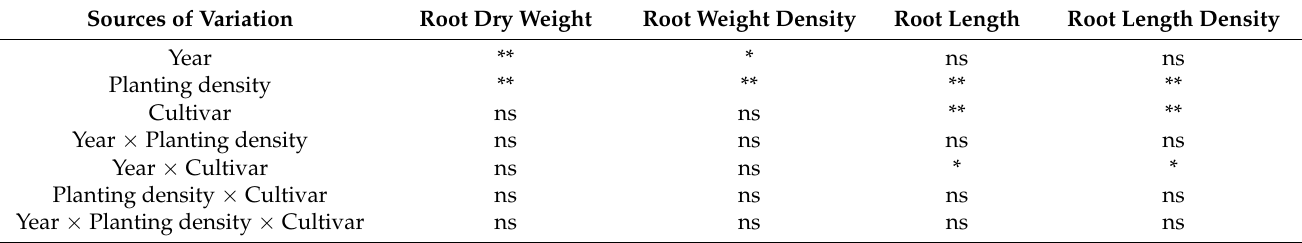
Table 3. ANOVA for the effects of years, planting densities, and cultivars on the maize root character- istics. *, significant at p < 0.05; **, significant at p < 0.01; ns, no significant